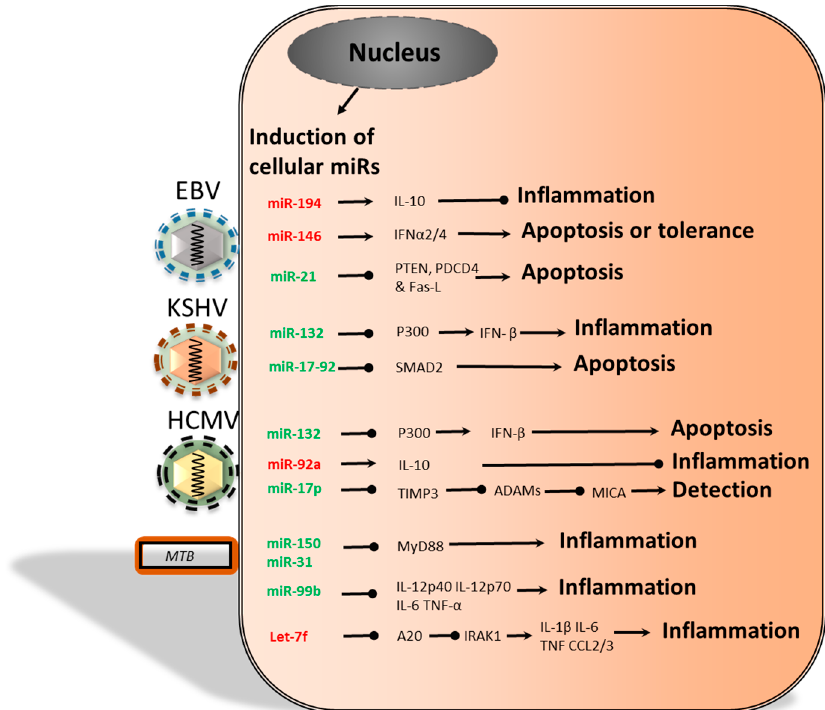
Figure 5. The decrease (red) or increase (green) of a particular miR, during infection, may alter the mRNA translation of specific cellular proteins. Altered protein expression can interfere with the inflammation, apoptosis or NK cell detection, which may benefit the pathogen. First, EBV-induced miRs may reduce inflammation and apoptosis, but may also stimulate IFN α 2/4, which could promote apoptosis or tolerance. Second, KSHV-induced cellular miRs may interfere with IFN- β and SMAD signaling, thereby affecting inflammation and apoptosis. Third, the HCMV-induced decrease of miR-92a could reduce inflammation by increasing IL-10, while miR-132 and miR-17p can affect apoptosis and detection by NK cells. Finally, the MTB - induced miRs have all been associated with decreased inflammation. PTEN, phosphatase and tensin homolog; SMAD2, small mothers against decapentaplegic 2; PDCD4, programmed cell death protein 4; Fas-L, Fas ligand.